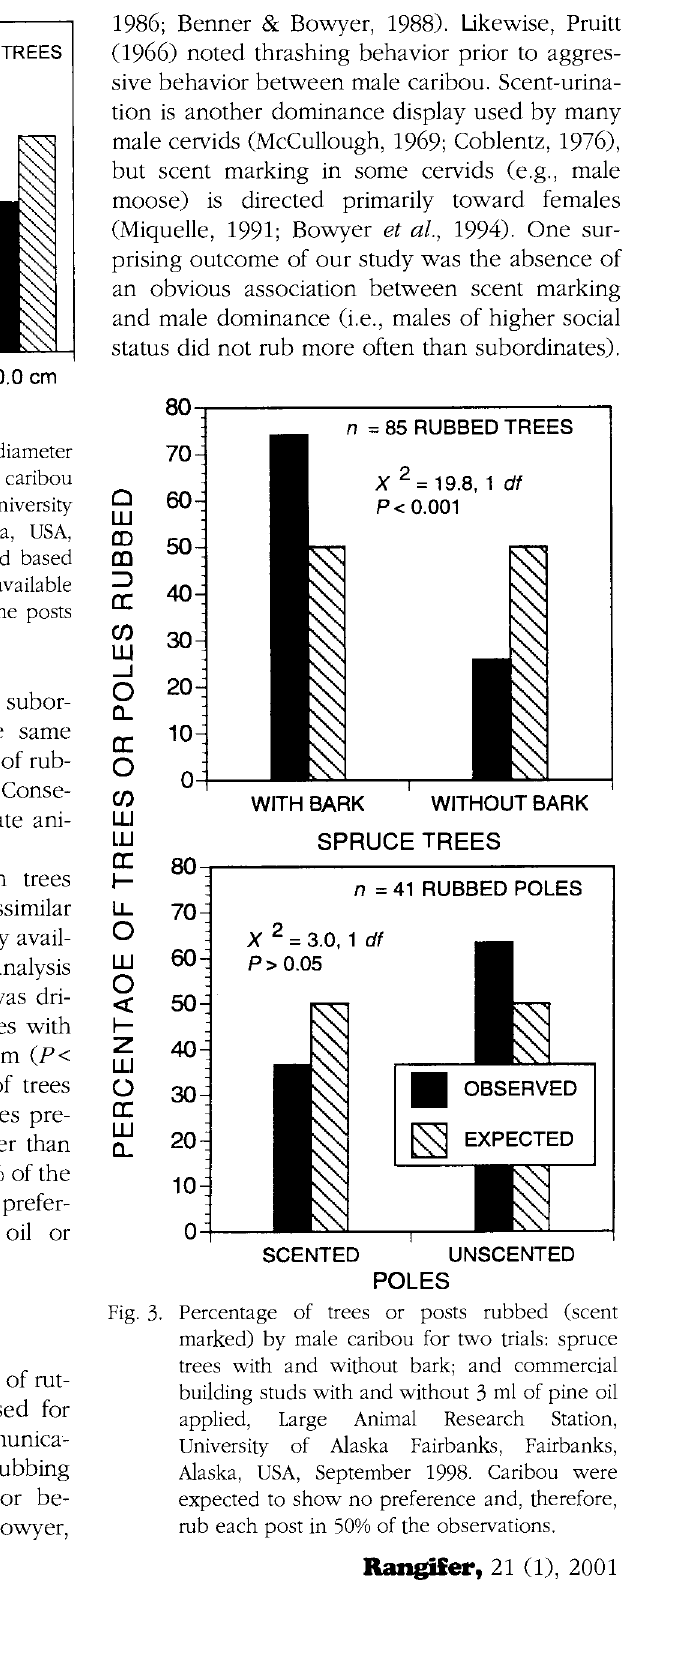
UNSCENTED POLES Percentage of trees or posts rubbed (scent Fig- 3. marked) by male caribou for two trials: spruce trees with and without bark; and commercial building studs with and without 3 ml of pine oil applied, Large